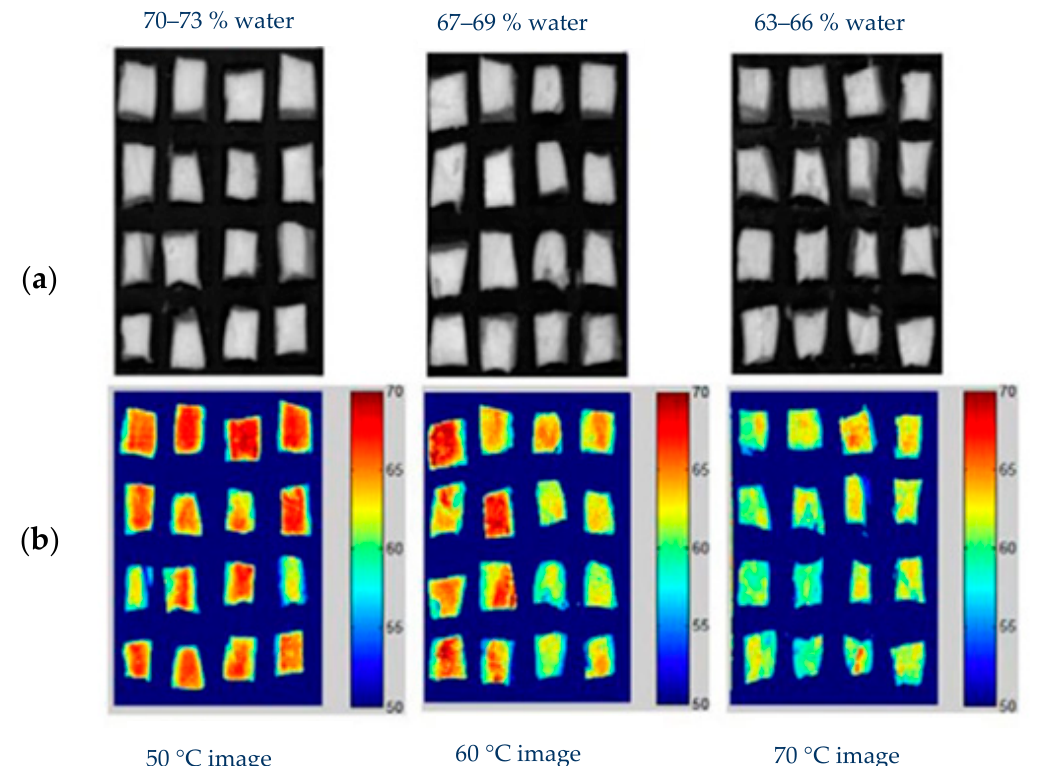
Figure 3. Hyperspectral images of chicken breasts ( a ), and water dispersion map of chicken breasts ( b ). Adapted from [208].